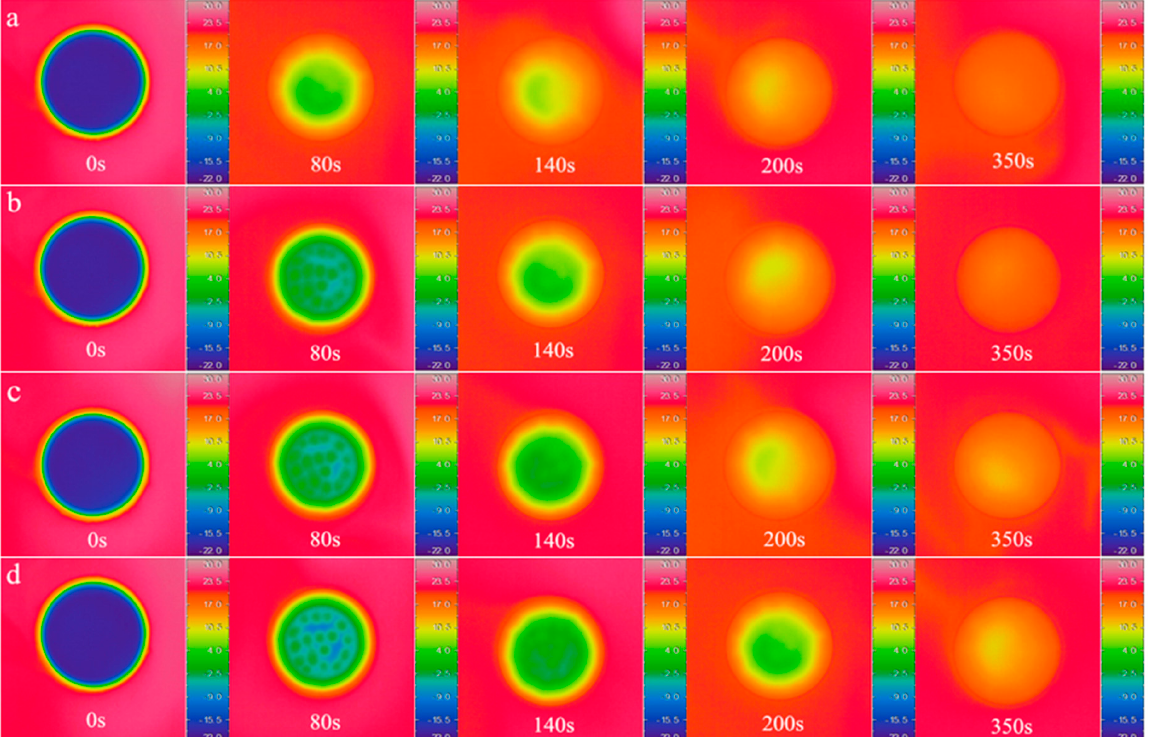
Figure 11. Infrared camera images of petri dishes with antifreeze fluid and different mass concentrations of MPCS under heating process: ( a ) antifreeze fluid ( b ) 10 wt % ( c ) 20 wt % ( d ) 30 wt %.